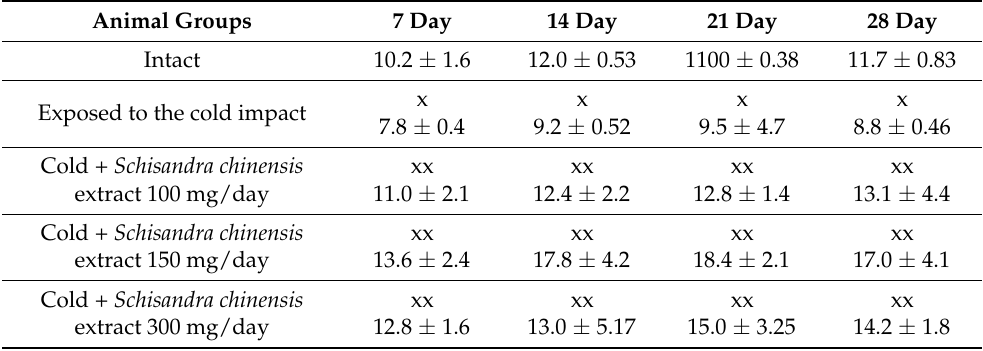
Table 4. Duration of running on the treadmill of rats under cold stress against the background of the introduction of Schisandra chinensis extract (in